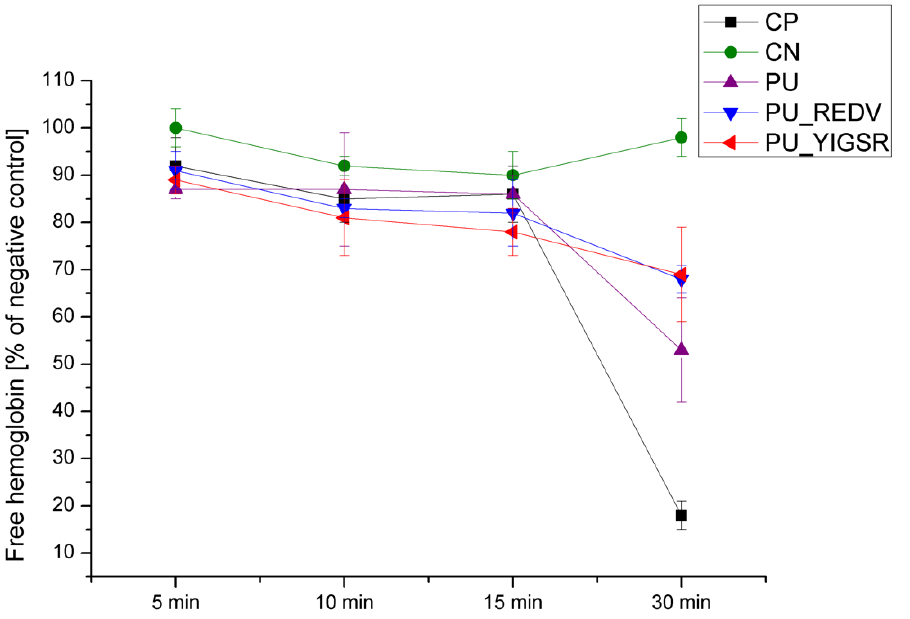
Figure 11. Results of whole blood clotting time assay.